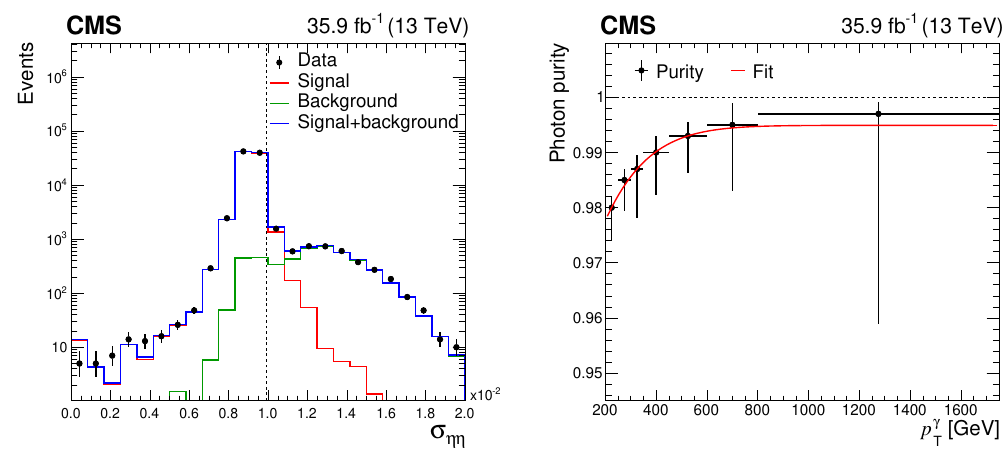
distribution using signal and background templates to extract a value Figure 1 . A fit to the σ ηη for the purity in the photon p bin of 300–350 GeV. The signal region is to the left of the vertical T dashed line (left). The purity, as a function of the photon p , is extracted from a fit to the σ T distribution in each p bin. The error bars show the total statistical and systematic uncertainty T and the solid line is the fit to the data points